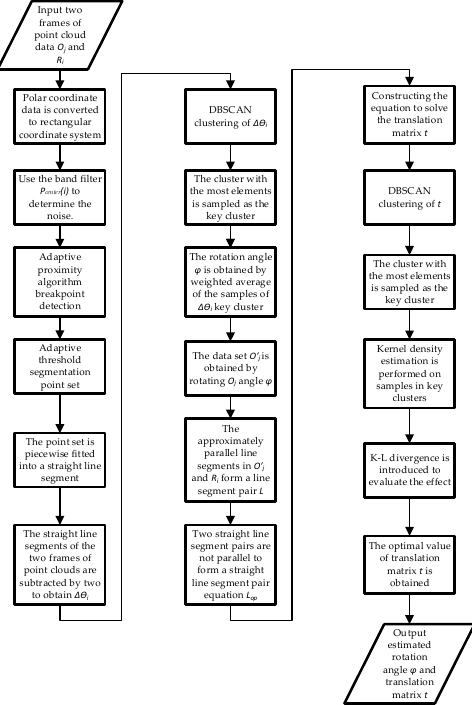
Figure 13. Description of the algorithm.